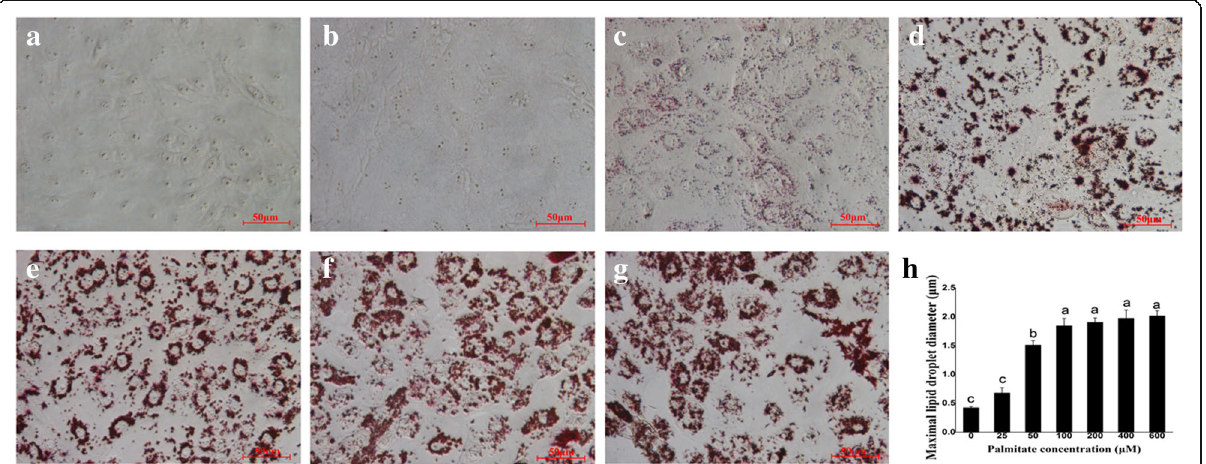
Fig. 3 Effect of palmitate on lipid droplet formation in pMECs. Cells were incubated for 24 h with different concentrations of palmitate (0 (control), 25, 50, 100, 200, 400, and 600 μ M) and then stained with Oil Red O and visualized by light microscopy with ×400 magnification. a 0 (control); b 25 μ M; c